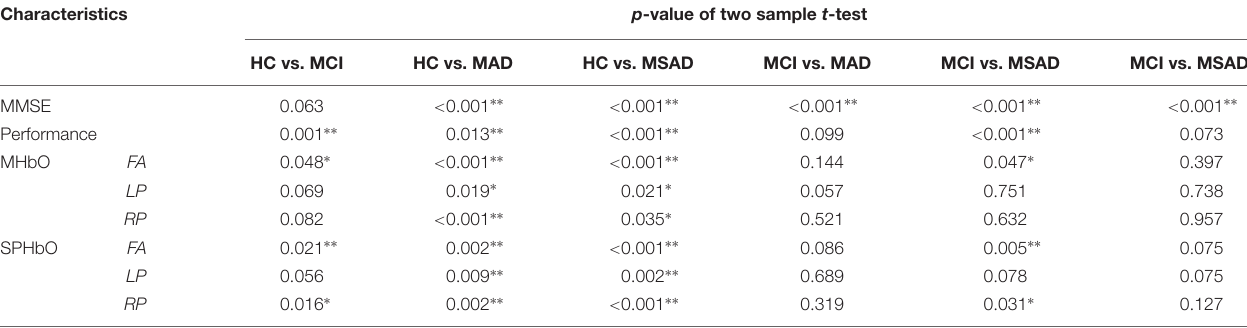
TABLE 2 | Summary of the statistical analysis results.